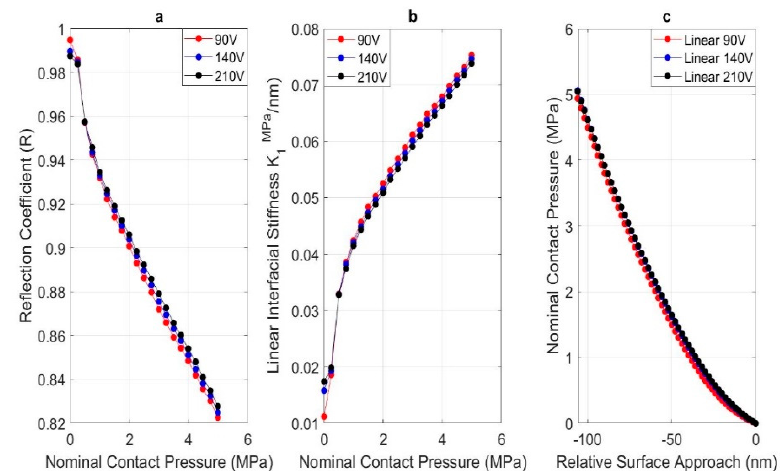
Figure 8. The influence of nominal contact pressure p 0 : ( a ) reflection coefficient; ( b ) linear interfacial stiffness; ( c ) pressure-relative surface approach derived from the linear interfacial stiffness at incidents amplitude excitations of 90 V , 140 V and 210 V .